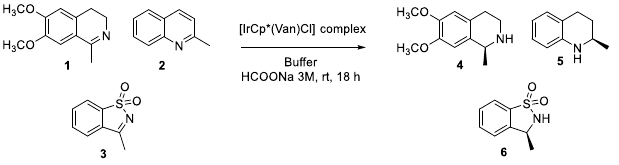
Figure 2. On the left: Van structure. On the right: Most significative chemical shift variations (ppm) of 1 H and 13 C resonances between free Van and the [Ir(Cp*)(Van)Cl] complex in the NMR spectra (see SI for complete